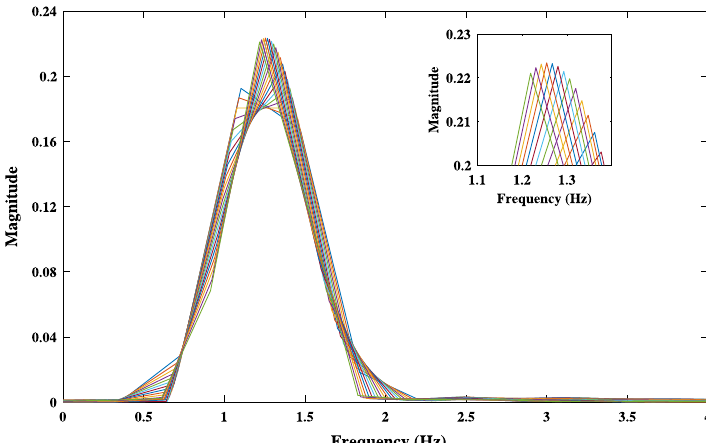
Fig. 5 An intuitive superiority of the combined spectra of TWV